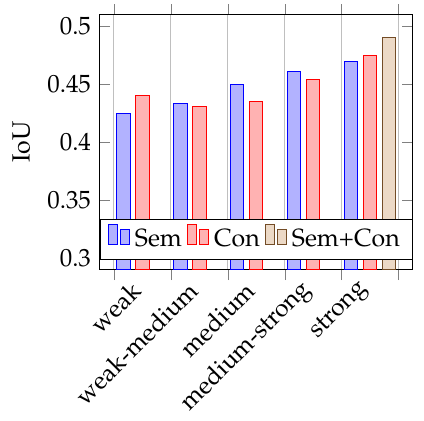
Figure 4. Mean IoU on real data.